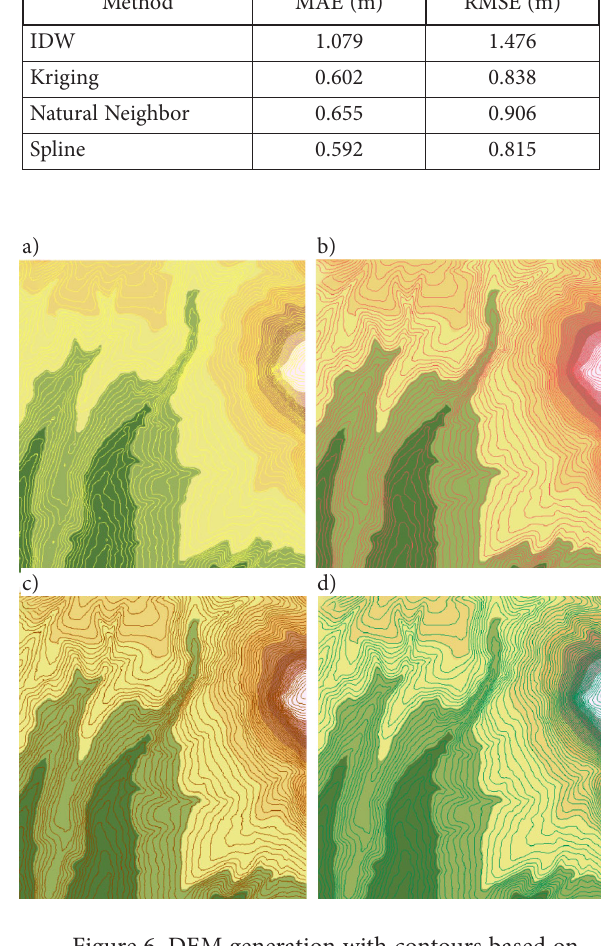
Figure 6. DEM generation with contours based on 12466 points: a) Spline, b) Natural Neighbor,